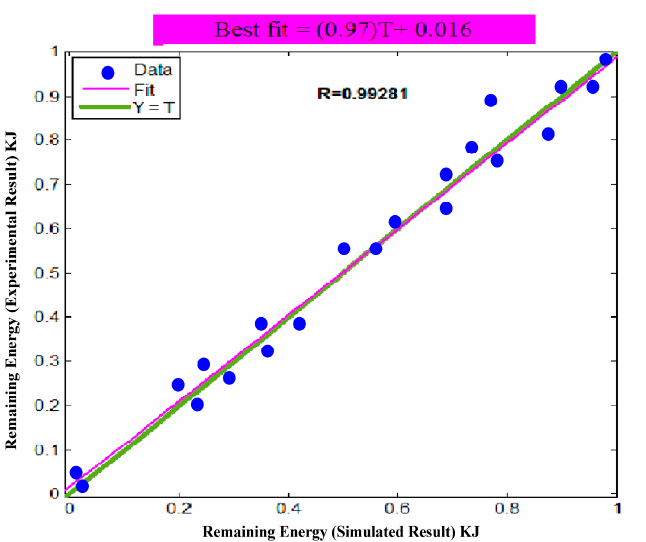
Figure 6. Regression plot (experimental vs. predicted) employing 3 factors, 10 neurons present in the hidden layer, and 1 output factor applying the ANN model.